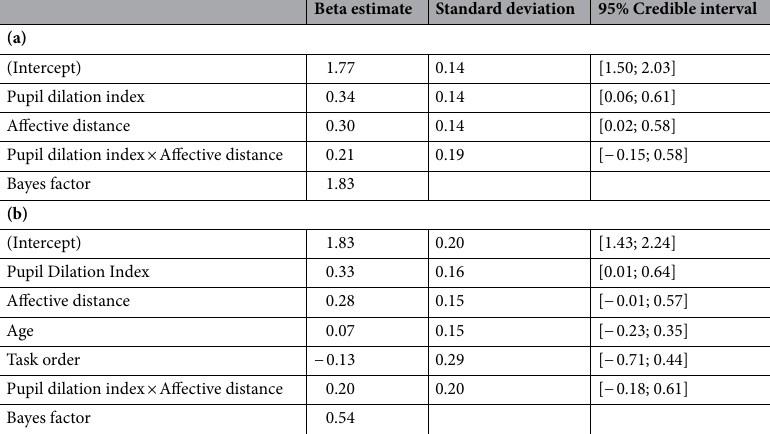
Table 1. Emotion regulation success explained by Pupil Dilation Index and affective distance. (a) Results from the Bayesian Linear Regression specified in Eq. (3a). Regulation success (measured on the 9-point SAM scale) was modelled by the mean-centred and standardized coefficients for Pupil Dilation Index (measured as mean difference in the pupil dilation curve for the Regulate > View contrast in the significant regulation time between 3.4 and 5.6 s) and Affective Distance (measured as the absolute value of the distance of the view rating from the neutral valence on the SAM scale). Pupil Dilation Index and Affective Distance were interacted, to test whether it might be easier or harder to reappraise with smaller or greater affective distances. (b) Augmenting the model (Eq. 3b) by the control regressors for Age and Task Order shows that the explanation of regulation success by PDI is robust to controlling for the age and the order in which participants completed the emotion regulation and dietary health challenge tasks. Model fits are given as the population level mean of the posterior distribution ± standard deviation (SD) and the 95% credible interval. Bayes Factors are given for a comparison to an intercept-only model.